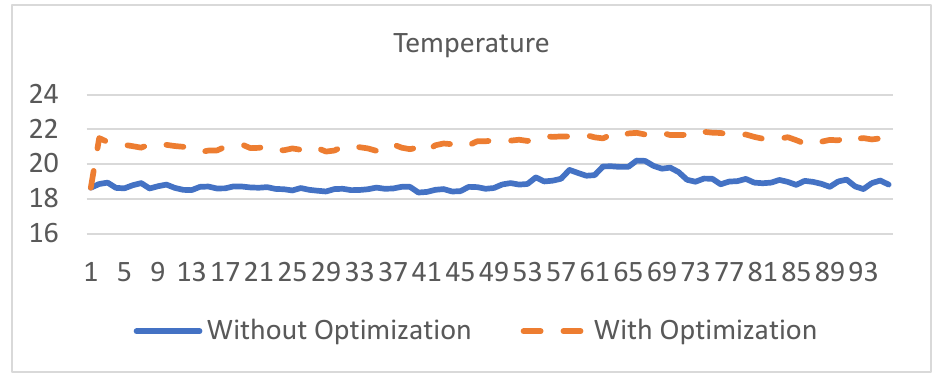
Figure 7. Comparison Results between Current and Optimized Indoor Temperature for Efficient Thermal Comfort Control.